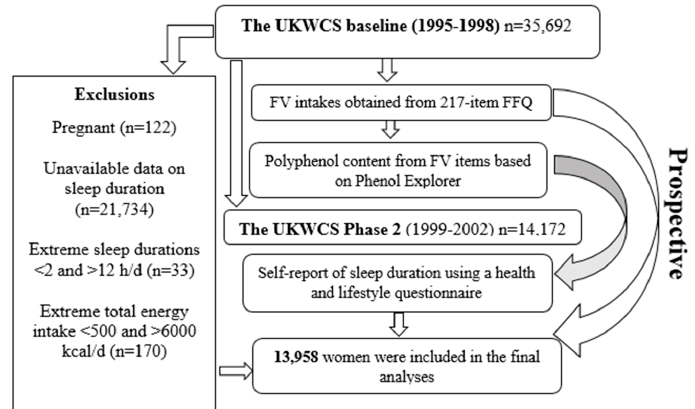
Figure 1. Participants’ flow chart. d (day), FFQ (food frequency questionnaire), FV (fruits and vegetables), h (hours), UKWCS (The UK Women’s Cohort Study).